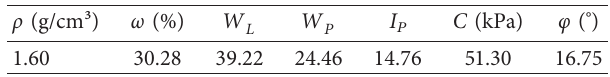
Table 1: Index properties of tested samples.